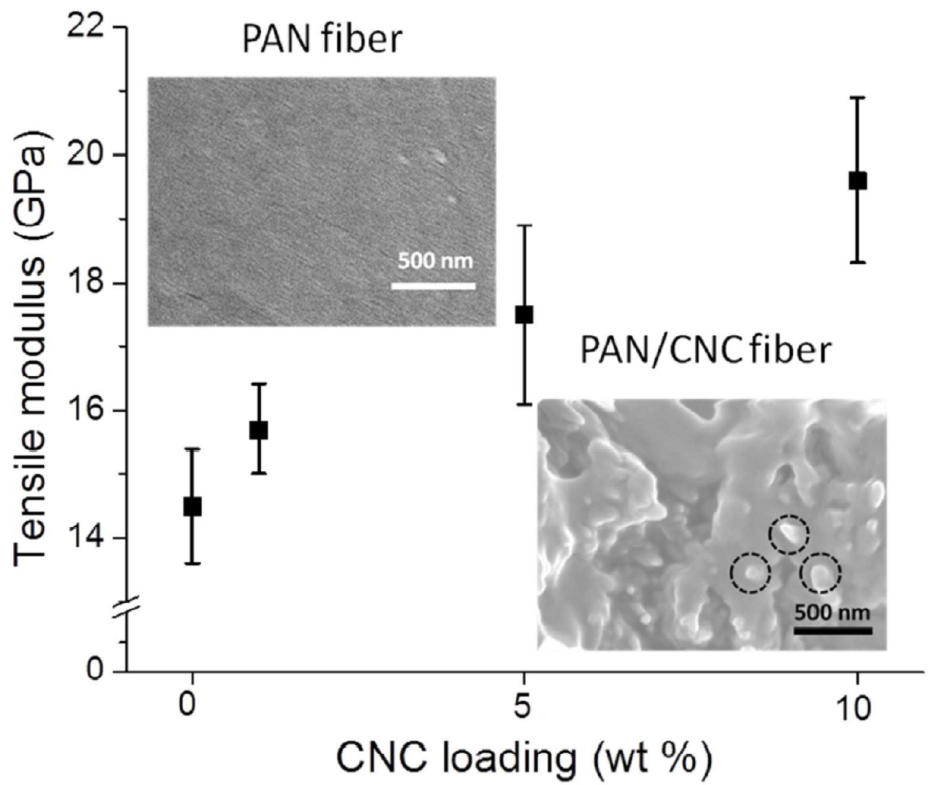
Figure 13. Young’s modulus change as the cellulose nanocrystal (CNC) content increased. Insets are SEM images of fracture surface of fibers of PAN and PAN/CNC 10 wt% (reprinted with permission from [114] , copyright 2015 American Chemical Society).